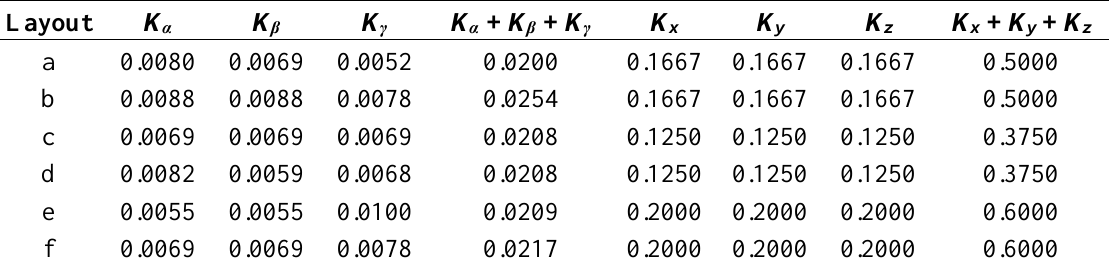
Table 1. The sensitivity coefficients of transformation parameter